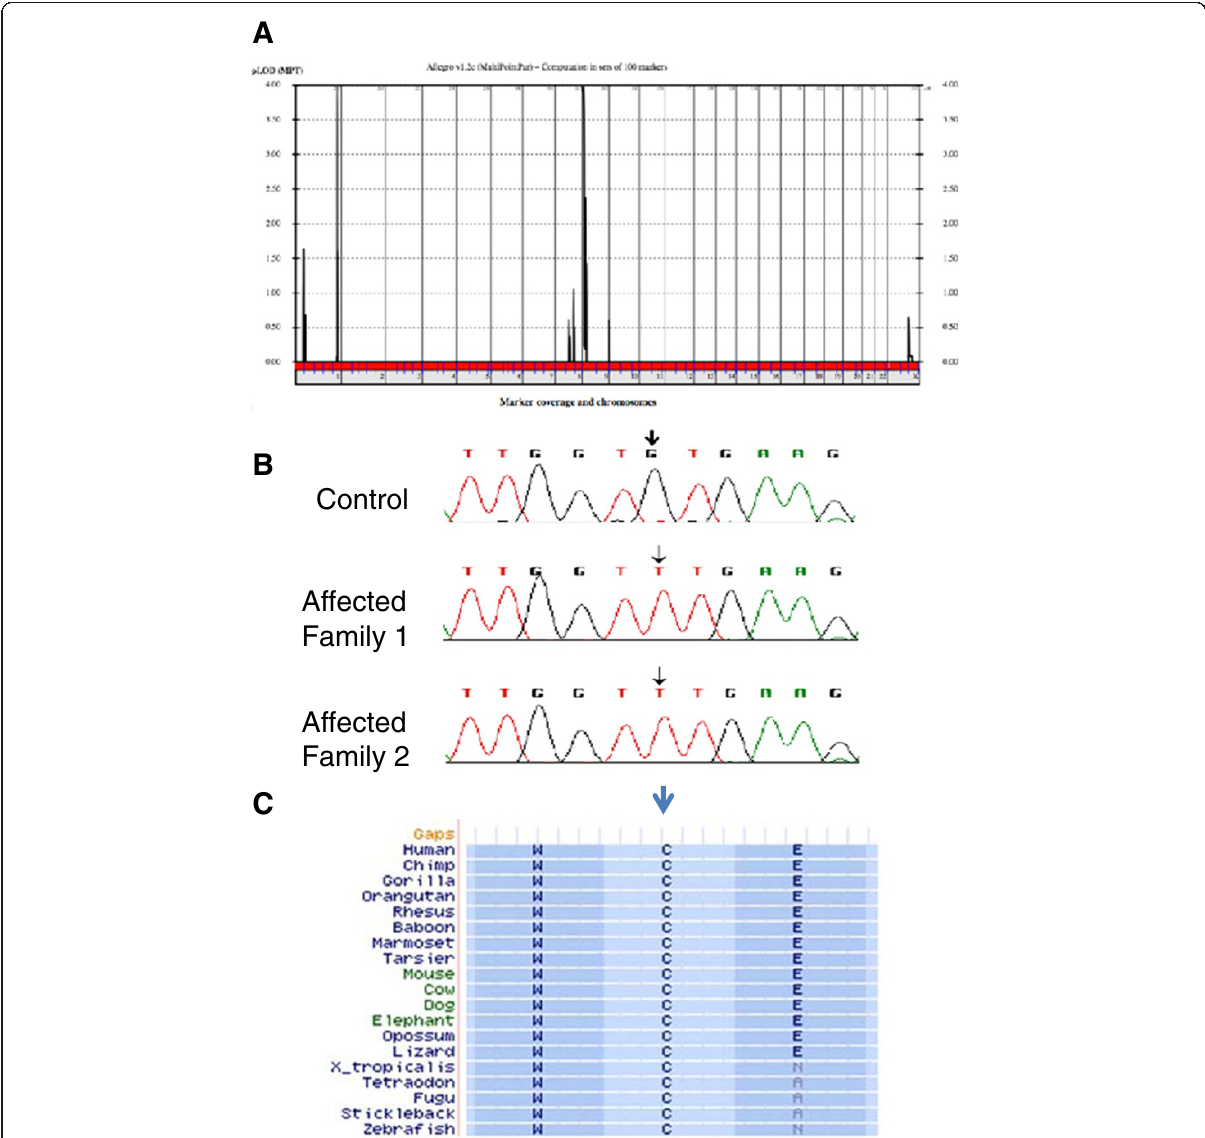
Figure 3 Molecular characterization of Families 1 and 2. A : Linkage plot for Family 1 with major peaks of pLOD score 4 achieved, both for chr. 9 and chr. 1. x-axis represents chromosomal position, y-axis represents pLOD score. B . Sequence chromatogram from control and affected individuals from Families 1 and 2, with mutant G to T residue at position chr9:2650382 (c.2117 G>T). C . Conservation of wild-type encoded C residue across annotated vertebrate